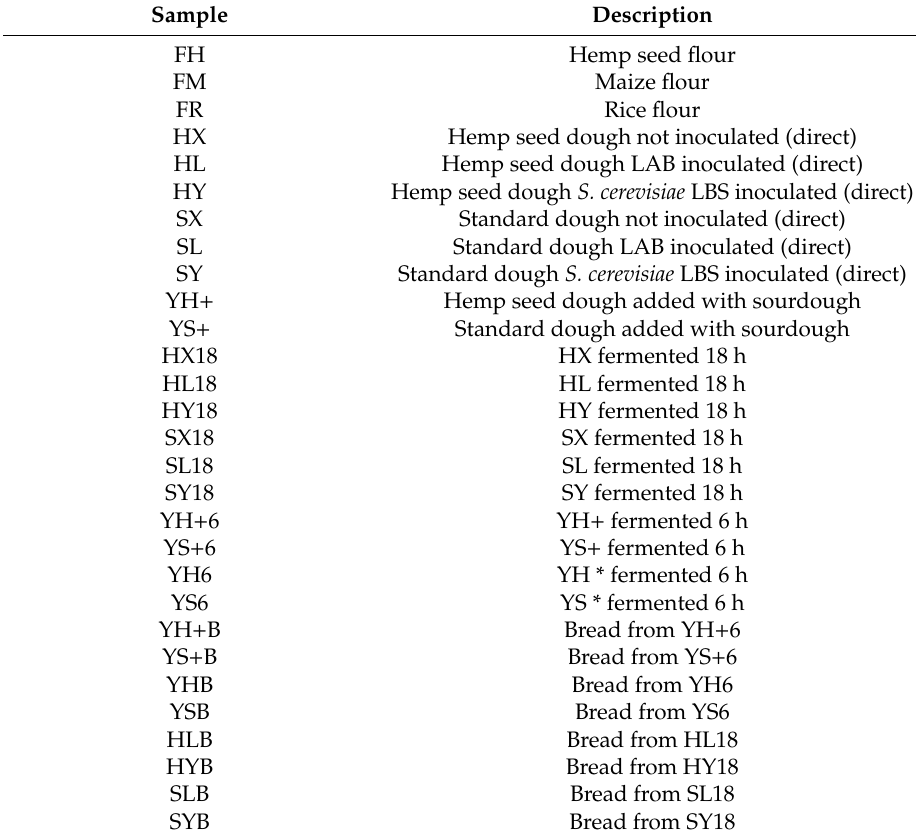
Table 1. Description of samples